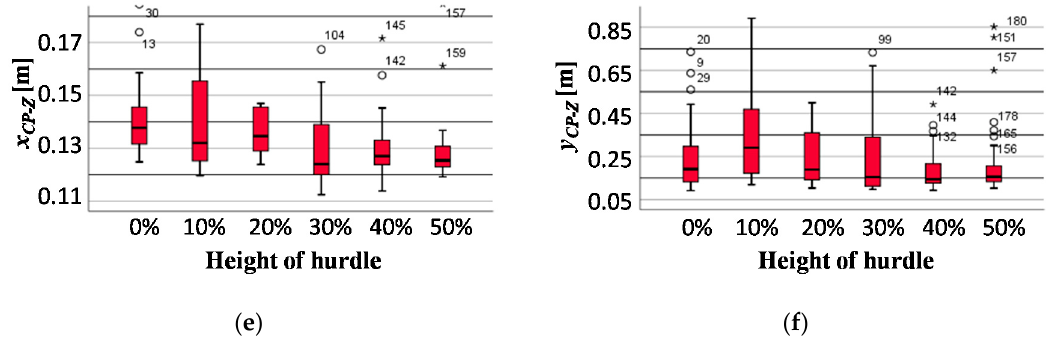
Figure 11. SD results of difference values of C-Z, CP-C and CP-Z according to the height percentage of lower limb (0%: Case 1; 10%: Case 2; 20%: Case 3; 30%: Case 4; 40%: Case 5; 50%: Case 6): ( a ) x COG — x ZMP ; ( b ) y COG — y ZMP ; ( c ) x CP — x COG ; ( d ) y CP — y COG ; ( e ) x CP — x ZMP ; ( f ) y CP — y ZMP .